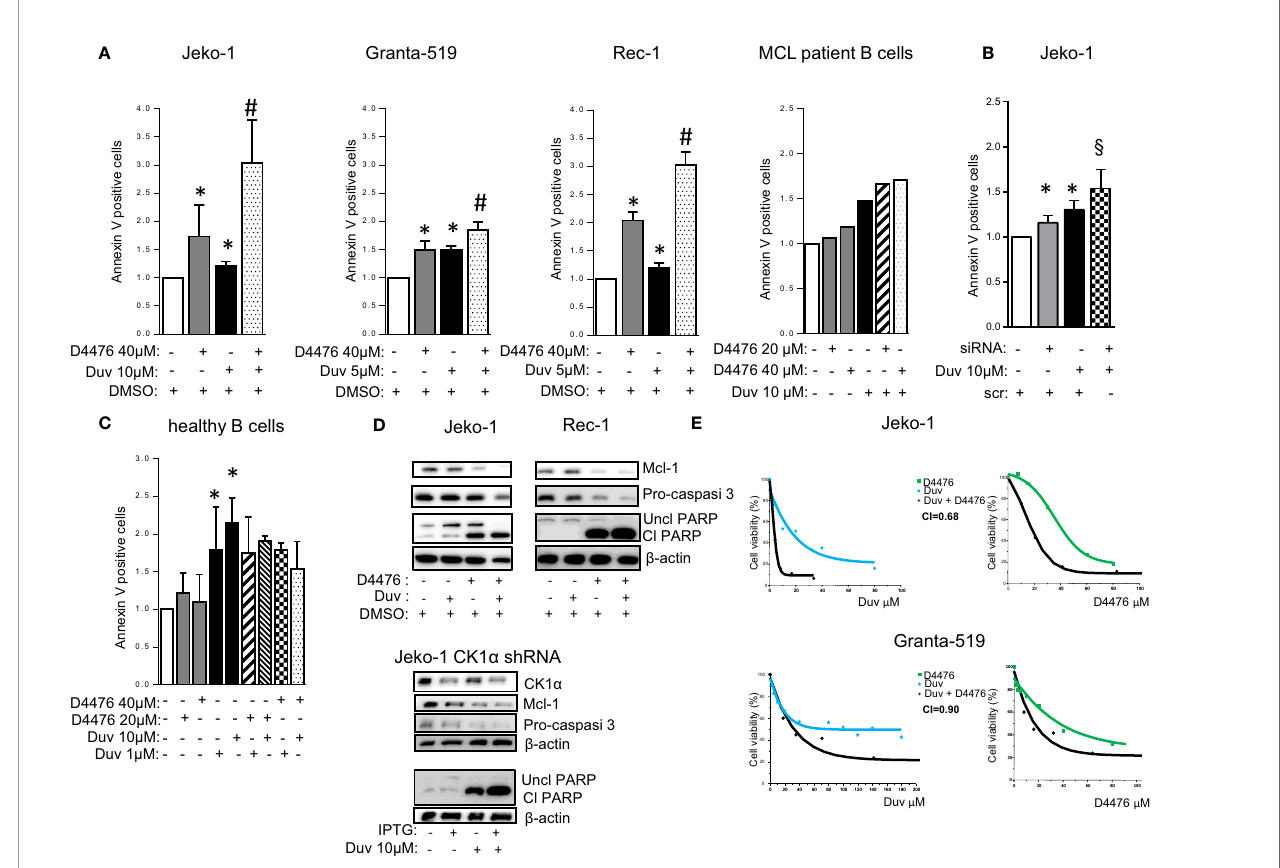
FIGURE 8 | CK1 a inactivation empowers Duvelisib induced cytotoxicity. (A – C) Annexin V staining and FACS analysis of MCL and healthy B cells in which CK1 a inactivation was associated with Duvelisib (Duv) treatment. (A) , MCL cell lines Jeko-1, Granta-519, Rec-1, were treated with Duv for 48h and with D4476 for the last 24h at the indicated concentrations. Puri fi ed B cells derived from 1 MCL patient were treated with Duv and D4476 for 24h. (B) Jeko-1 wt cells were electroporated with CSNK1A1 directed siRNAs for 48h and treated with Duv 10µM alone or in combination with CK1 a silencing for the last 24h. (C) Healthy B cells (n=4) were treated with Duv 1µM or 10µM, D4476 20µM or 40µM or the combination of both compounds for 24h. Data represent the mean ± SD of at least n=6 (Jeko-1), n=9 (Granta-519), n=3 (Rec-1) independent experiments normalized over control. * indicates p < 0.05 compared to DMSO treated cells, # indicates p < 0.05 between samples treated with Duvelisib together with D4476 and Duvelisib or D4476 alone; § indicates p < 0.05 between samples treated with Duvelisib together with CK1 a silencing and Duvelisib or CK1 a silencing alone. (D) Representative WB analysis of Mcl1, Procaspase-3, and PARP cleavage in Jeko-1 and Rec-1 treated with Duv (10 µM for Jeko-1 and 5µM for Rec-1) for 48h and with D4476 40 µM for the last 24h (upper panel) and Jeko-1 IPTG inducible CSNK1A1 directed shRNA clone (named CK1 a shRNA) treated with IPTG 500µM for 13 days and with Duv 10 µM for the last 24h, (lower panel). CK1 a antibody was used to monitor the silencing ef fi cacy. b actin was used as loading control. The fi gure shows a representative WB, that was performed on at least 3 independent experiments. (E) Synergistic effect of D4476 and Duv in reducing cellviability. Dose response curve of Jeko-1 (upper) and Granta-519 (bottom) incubated for 72 hours with increasing concentrations of D4476 alone, (green squared curve), of Duv alone (light blue star curve), and with the combination of D4476 and Duv (black fi lled circle curve). Cell viability was assessed with MTT test and reported as percentage over untreated cells. In Jeko-1, IC50 for D4476 alone was 41.5 m M and for Duv alone was 16,85µM. IC50 for D4476 used in combination with Duv was 18,63 m M, while IC50 for Duv used together with D4476 was 3,95 m M. The CI between D4476 and Duv was calculated as to be 0.68. In Granta-519, IC50 for D4476 alone was 32 m M and for Duv alone was 71µM. IC50 for D4476 used in combination with Duv was 14,41 m M, while IC50 for Duv used together with D4476 was 32,27 m M. The CI between D4476 and Ibrutinib was calculated as to be